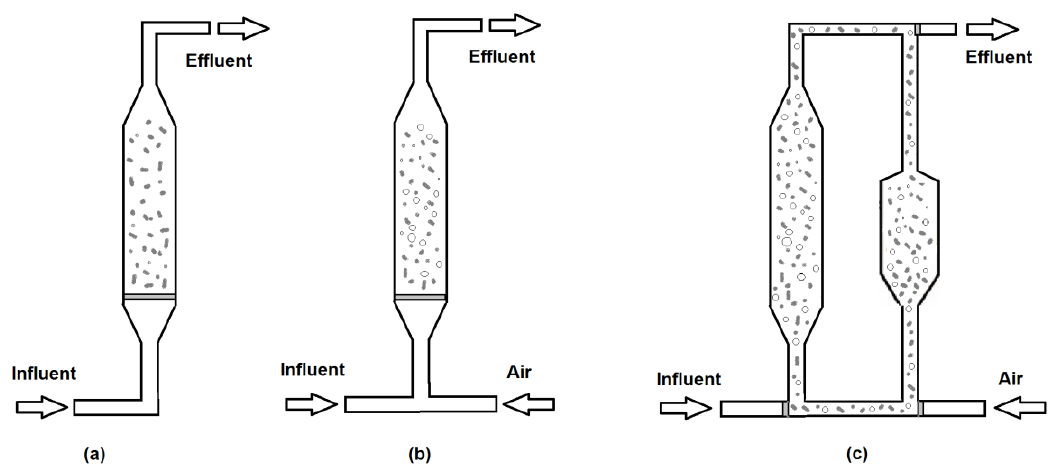
Figure 1. Di ff erent type fluidized-bed bioreactors (FBB): ( a ) two-phase (liquid–solid); ( b ) three-phase (gas–liquid–solid); ( c ) three-phase (gas–liquid–solid) with particle